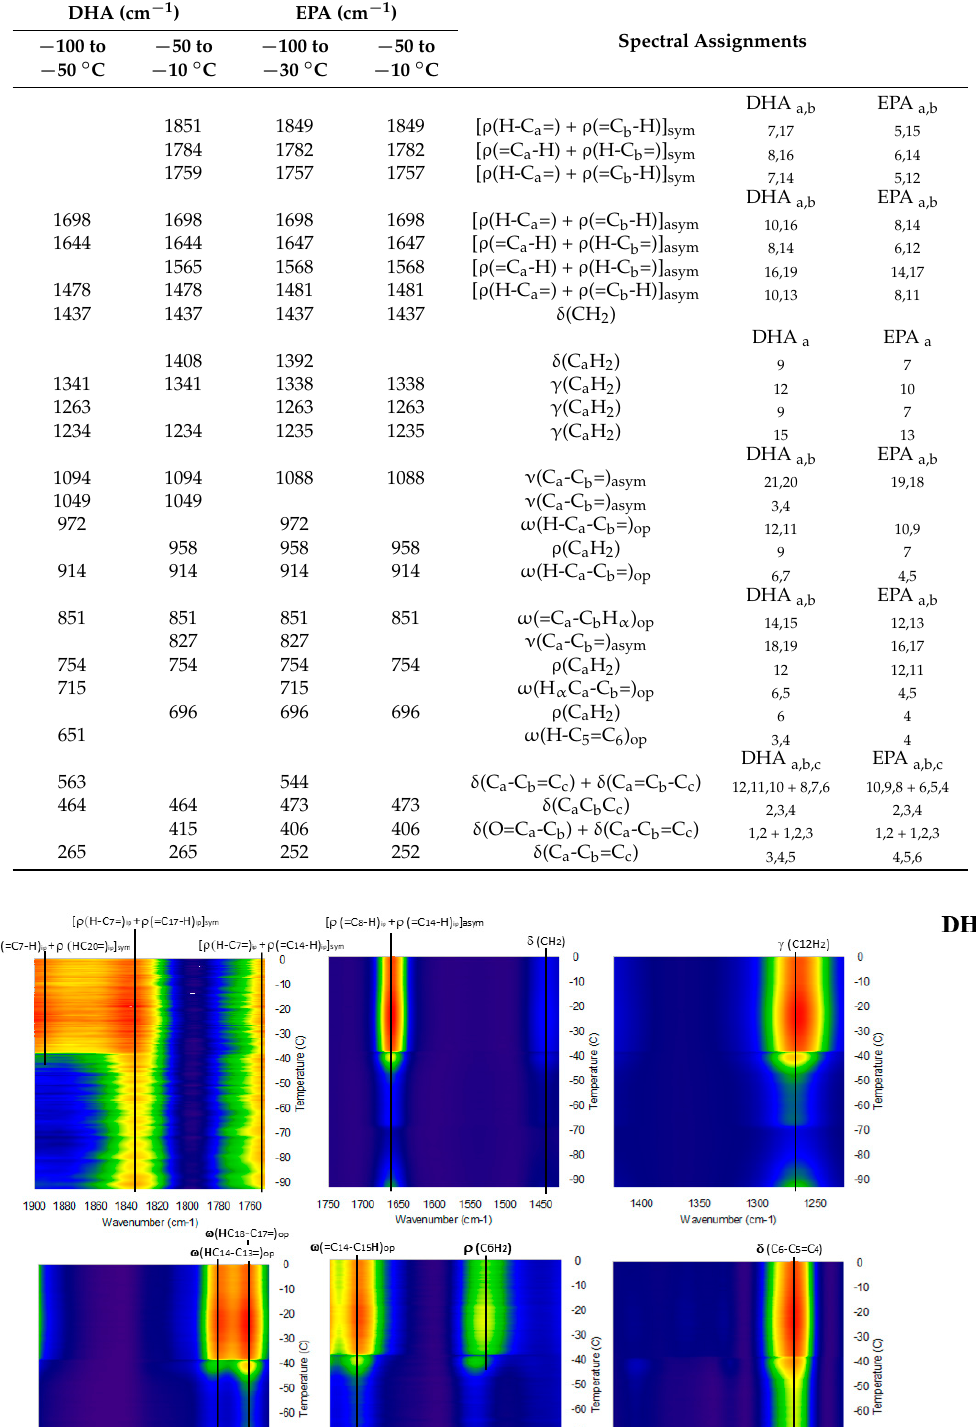
Table 1. EPA and docosahexaenoic acid (DHA) modes and vibrational assignments; a, b, c are carbon numbers from methyl end. Original DHA data from ref. [17].